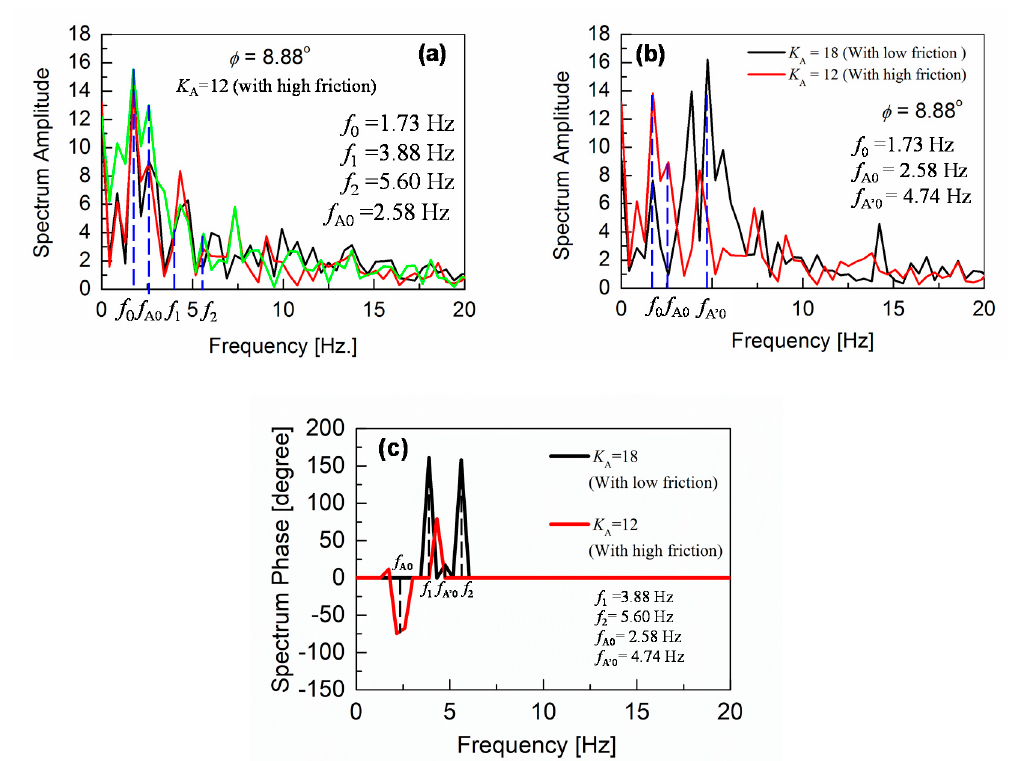
Figure 13. ( a ) Amplitude plot, which shows the Fourier analysis of the angular-pitch velocity data when the robot is allowed to walk with higher feet friction and reduced value of K A = 12 on a surface of φ = 8.88° inclination. ( b ) Comparison of amplitude plots, which demonstrates the shift in the additional frequency due to the feedback control from f A’0 = 4.74 to f A0 = 2.58 Hz, when lowering K A from 18 to 12, as possible by the increased feet friction. ( c ) Phase plot, which confirms the frequency-peak shift to a lower value, due to lowering of the feedback gain K A at a higher surface friction. A tolerance value of 33% of the absolute maximum in the amplitude spectrum is used for the phase-plot calculation.